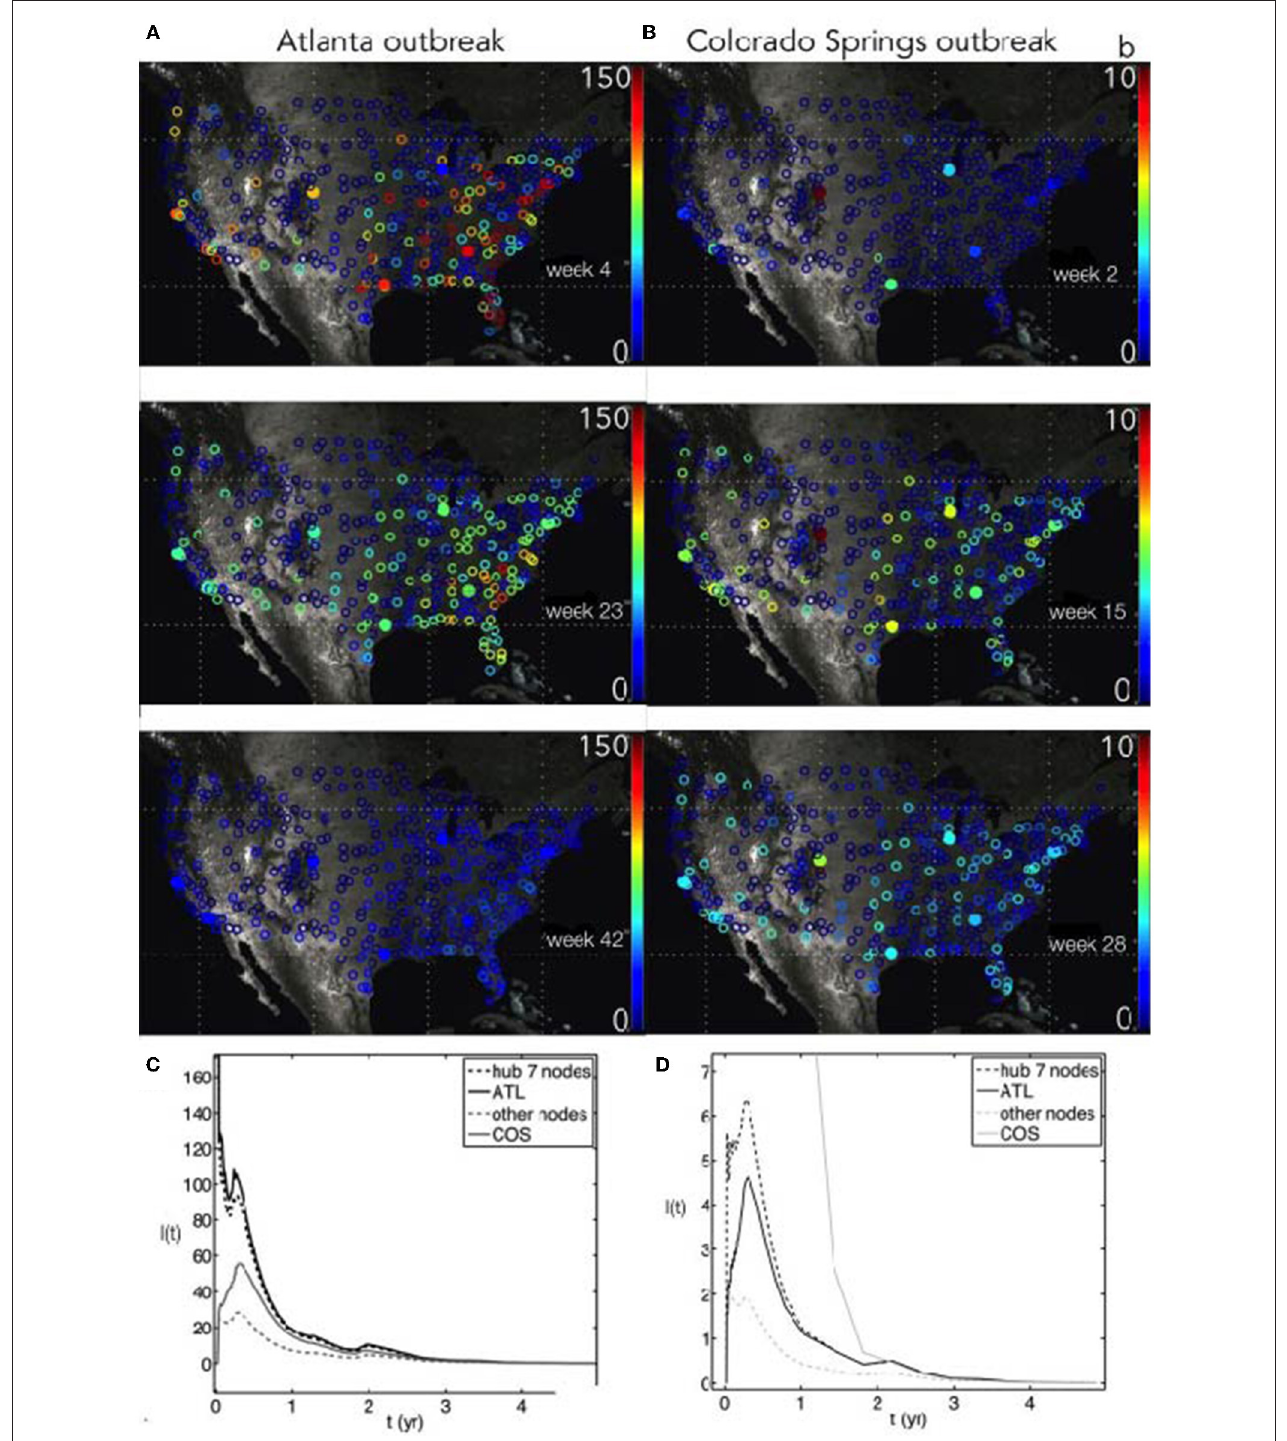
FIGURE 2 | (A,B) Outbreak of a stochastic seasonal SIS influenza-like infection on the USA flight network, with origins either in Atlanta (ATL) (A) or Colorado Springs (COS) (B) . The seasonal force of infection is scaled using the Google Flu Trends timeseries for infectivity β ( t ), where the baseline β 0 = 12 and γ = 3. After some time (top to bottom), the disease propagates throughout the network and tends to fade out due to stochastic fluctuations and dilution. The colorbar shows the number of infected population units for each node, I ( t ). (C,D) Time course of SIS outbreaks for the networks in the above panels, showing the average infected for the seven most connected hubs, the average infected for all other nodes, and the specific nodes ATL and COS.